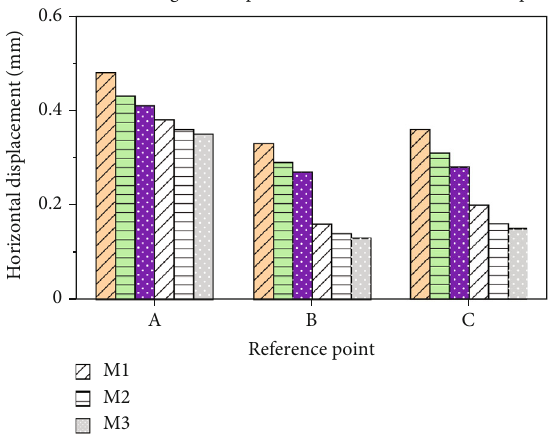
Figure 17: Di ff erent values of horizontal displacement at the slope reference points for di ff erent rooting depths.